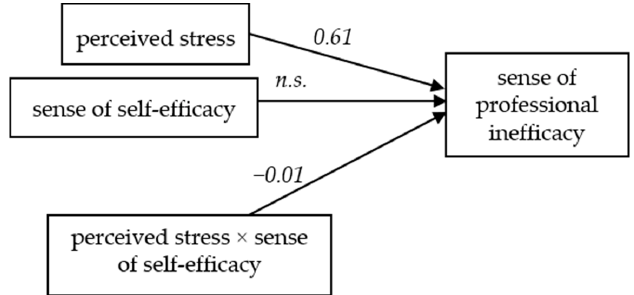
Figure 4. The model of relations between the perceived stress and the sense of professional inefficacy, moderated by the sense of self-efficacy ( n.s. : not